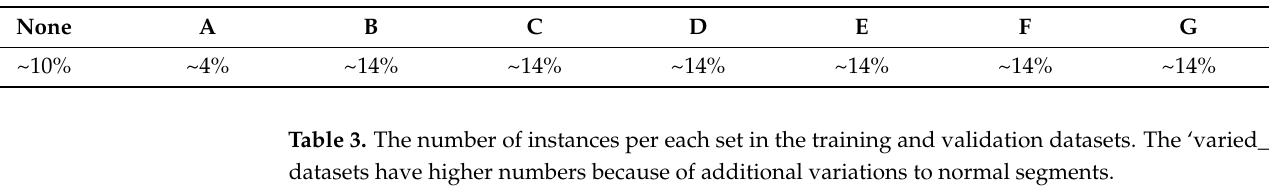
Figure 3. An example of augmentations introduced with smoothing and varying the amplitudes of normal segments. Table 2. Shares of classes in the datasets. NF and A classes are lesser due to the lack of signal rotation. The higher share of NF class to A is a result of faulty signals being labeled as NF when the RMS is higher than 90% of the nominal RMS value.